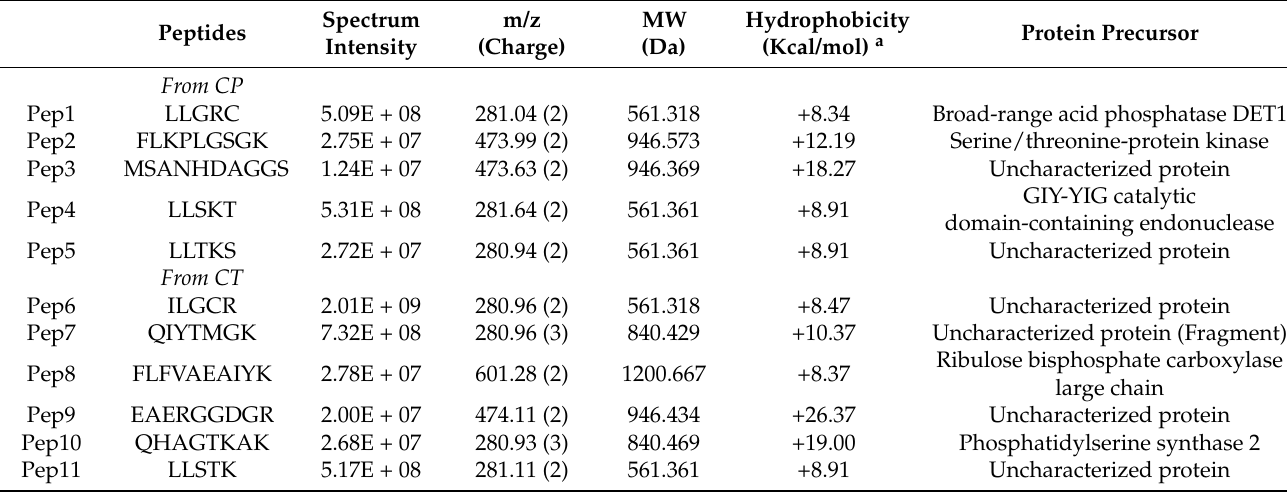
Figure 1. Degree of the hydrolysis (DH) trend and digestion efficiency of protein from C. pyrenoidosa . ( a ) DH at different time points within the first 3.5 h of enzymatic digestion. ( b ) SDS-PAGE analysis of hydrolysates sampled at different hydrolysis time points. RM: raw protein extract; CP: C. pyrenoidosa proteins digested by pepsin; CT: C. pyrenoidosa protein digested by trypsin. Table 1. Short peptides ( ≤ 10 aa) identified from CP and CT by